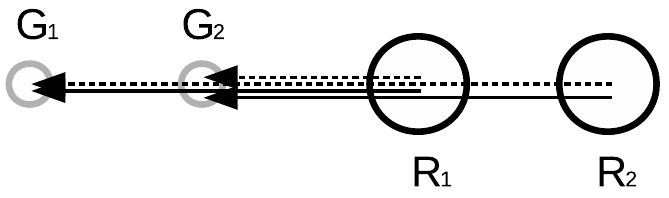
Figure 8. Two robot-goal assignment—case